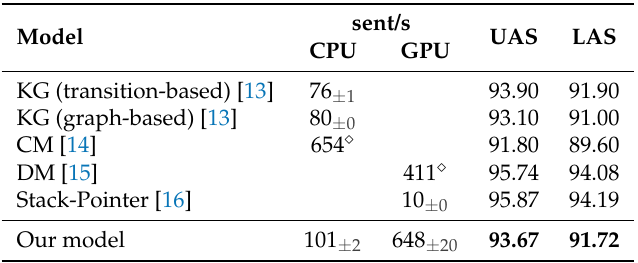
Table 1. Model’s speed and accuracy compared with existing dependency parsers on the PTB test set. (cid:5) speeds taken from the original